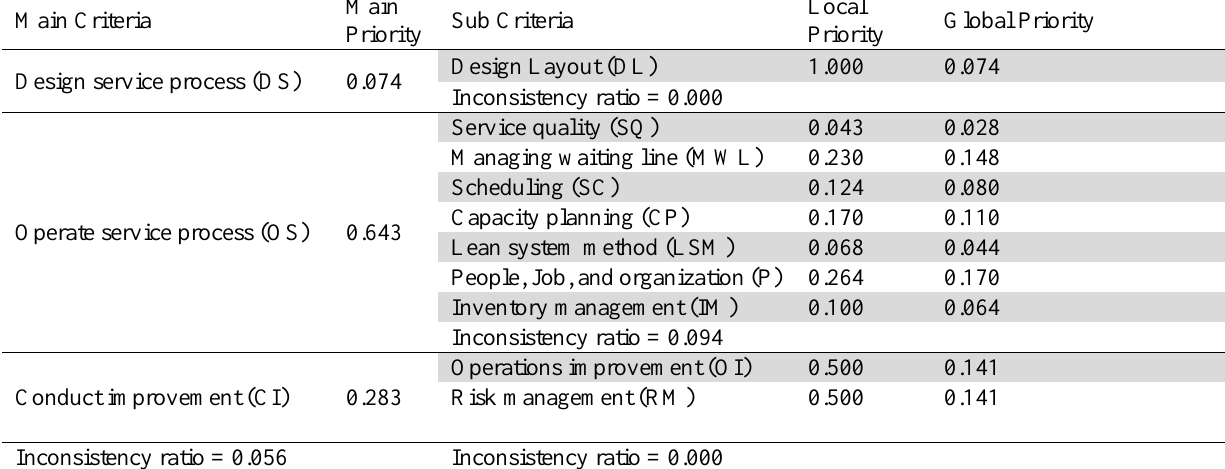
Weighting priority values for each criterion